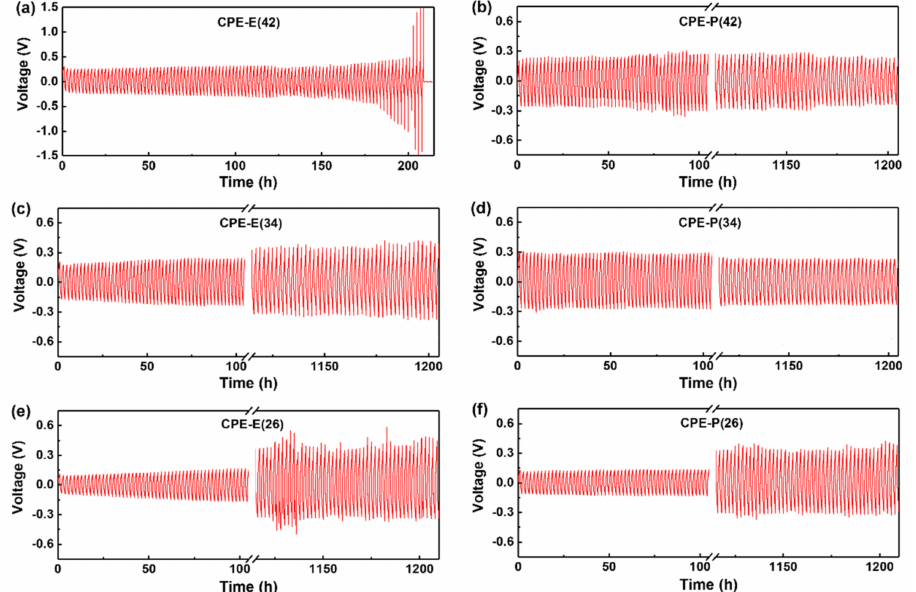
Figure 5. The voltage profiles of galvanostatic cycling of different lithium symmetric cells at a current density of 0.05 mA cm − 2 at 20 ◦ C: ( a ) Li|CPE-E(42)|Li, ( b ) Li|CPE-P(42)|Li, ( c ) Li|CPE-E(34)|Li and ( d ) Li|CPE-P(34)|Li cells at 20 ◦ C, ( e ) Li|CPE-E(26)|Li, and ( f ) Li|CPE-P(26)|Li